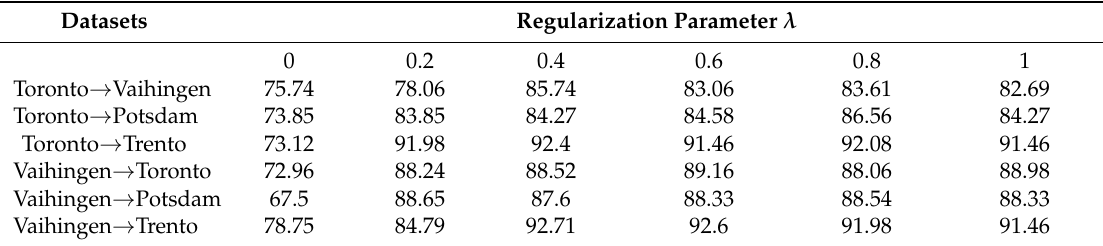
Table 3. Sensitivity analysis with respect to the regularization parameter λ . Results are expressed in terms of OA [%] and AA [%] over the 12 scenarios.